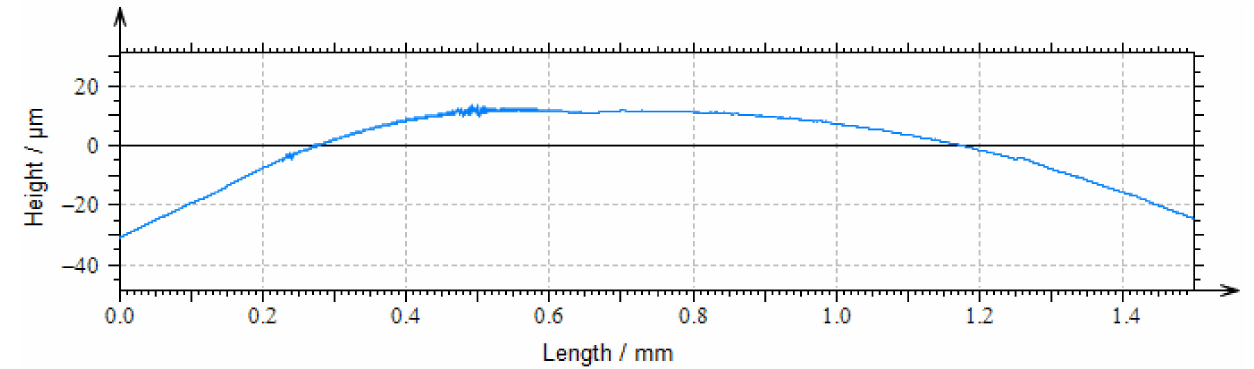
Figure 16. Primary profile of the measured tool tip.